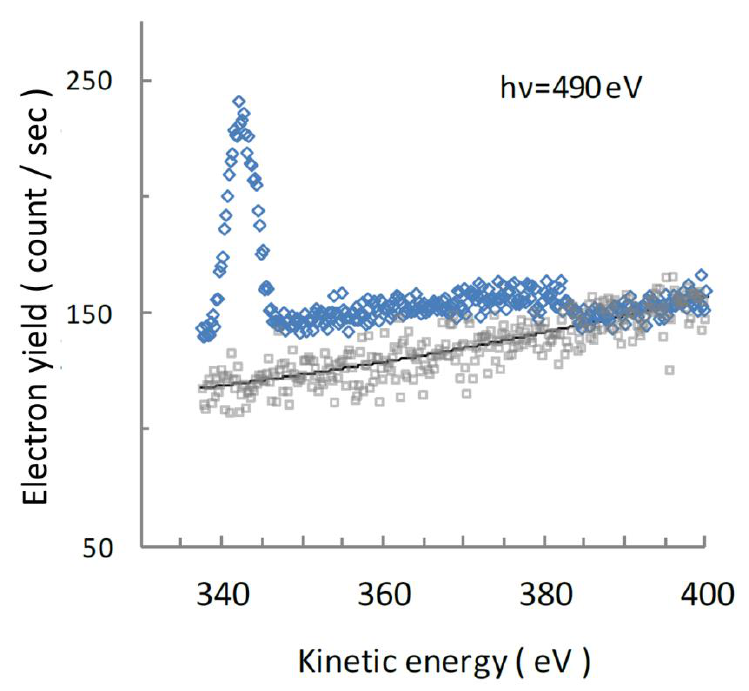
Figure 3. Electron kinetic energy spectra for aqueous UMP at pH = 7.5 ( ◇ ) and the liquid water ( □ ) at the X-ray photon energy of 490 eV.